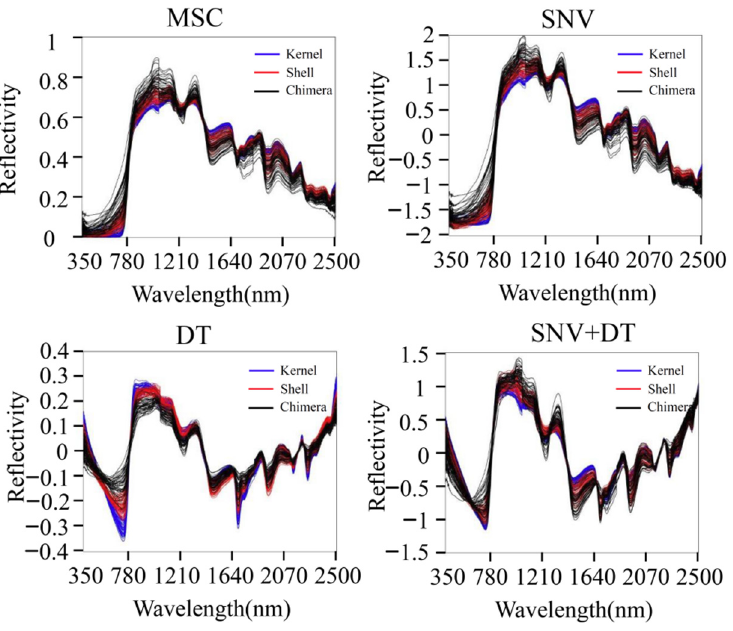
Figure 5. Spectra after different preprocessing methods.